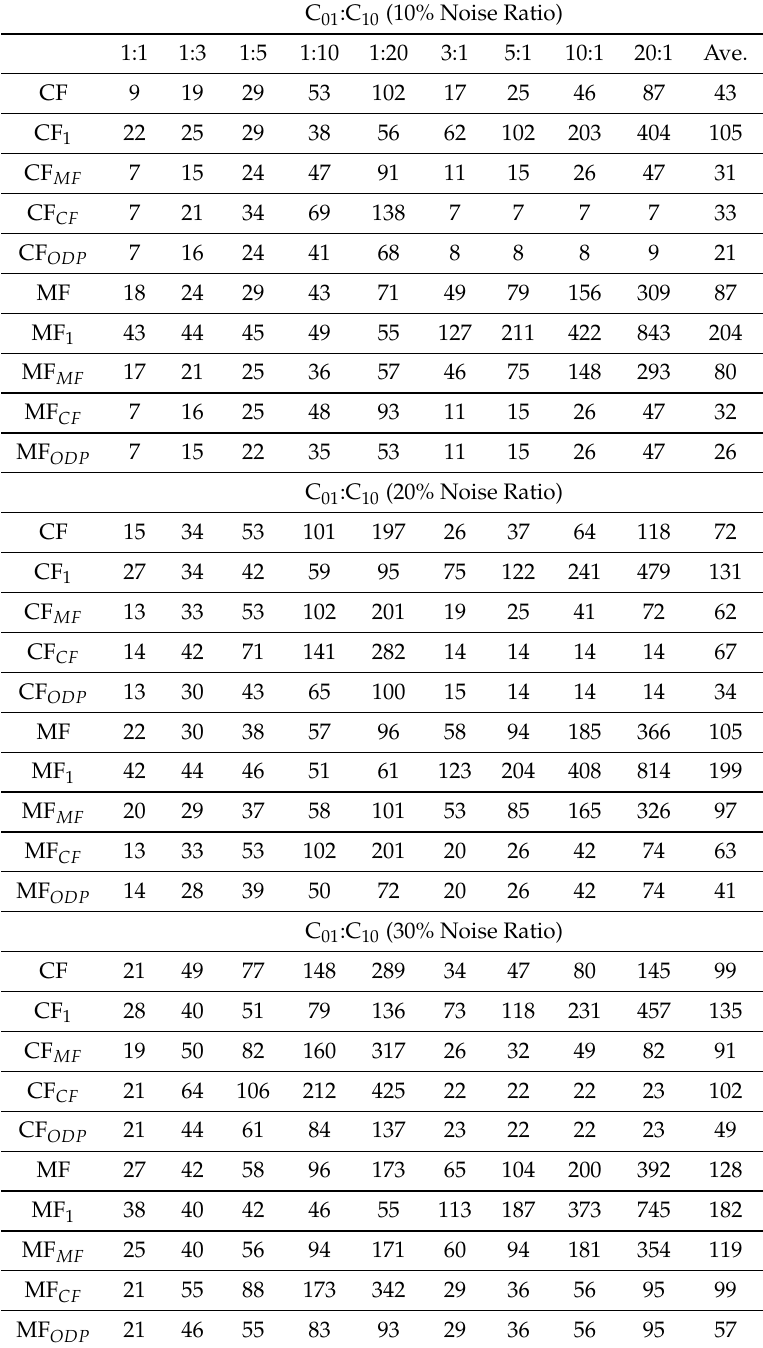
Table 14. Cost comparisons on Promoter in the case that the noise ratio and noise-free dataset are